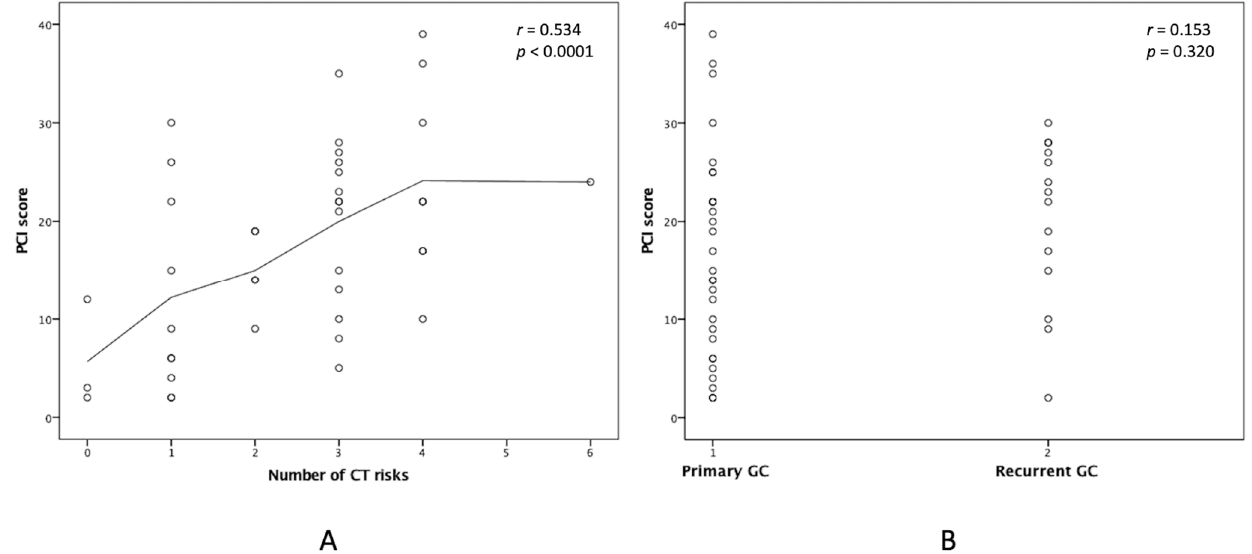
Figure 2. Relationships between PCI score and clinical factors. Linear regression analyses were per- formed, which showed ( A ) a high correlation between PCI score and number of CT prognostic risks ( r = 0.534, p < 0.0001) and ( B ) an irrelevant correlation between PCI score and GC primacy (r = 0.153, p = 0.320). PCI, peritoneal cancer index; CT, computed tomography; GC, gastric cancer. Table 1. Demographic and clinical characteristics of the metastatic gastric cancer patients who un- derwent CRS/HIPEC.